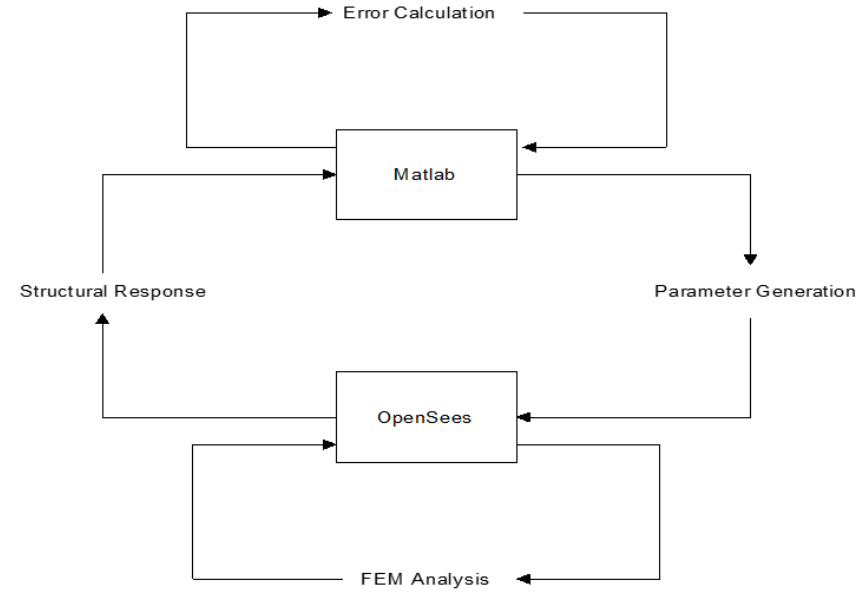
Figure 7. Integration scheme of Matlab and OpenSees software.